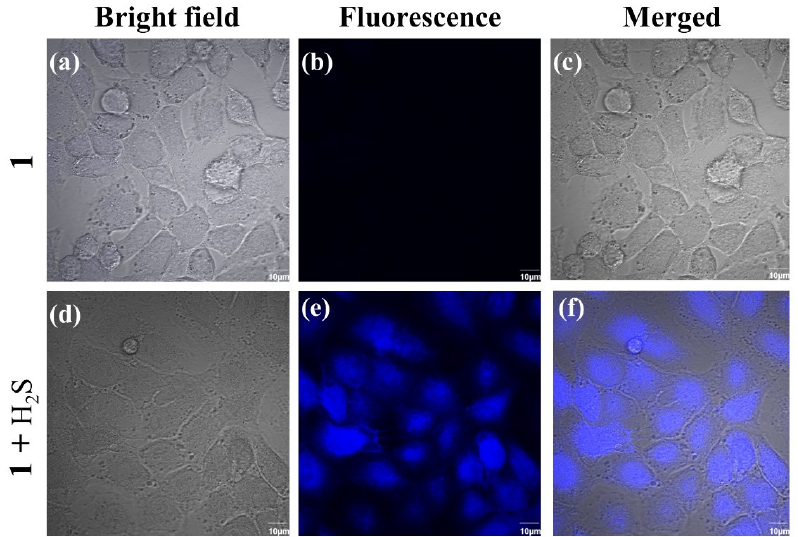
Figure 6. ( a – c ) Confocal fluorescence images of MCF-7 cells incubated with probe 1 (10 μM) for 30 min, and then ( d – f ) subsequently incubated with H 2 S (100 μM) for another 30 min (scale bar = 10 μm).